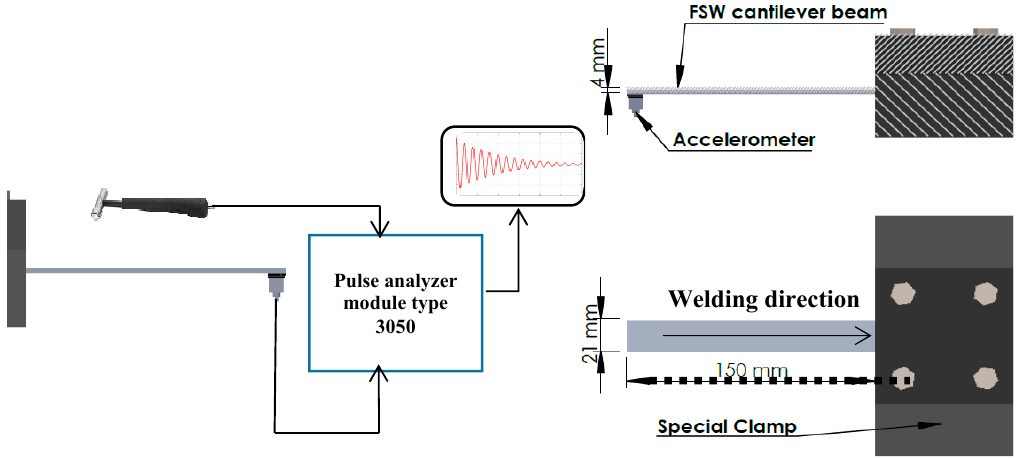
Figure 3. Vibration apparatus and free vibration test setup.